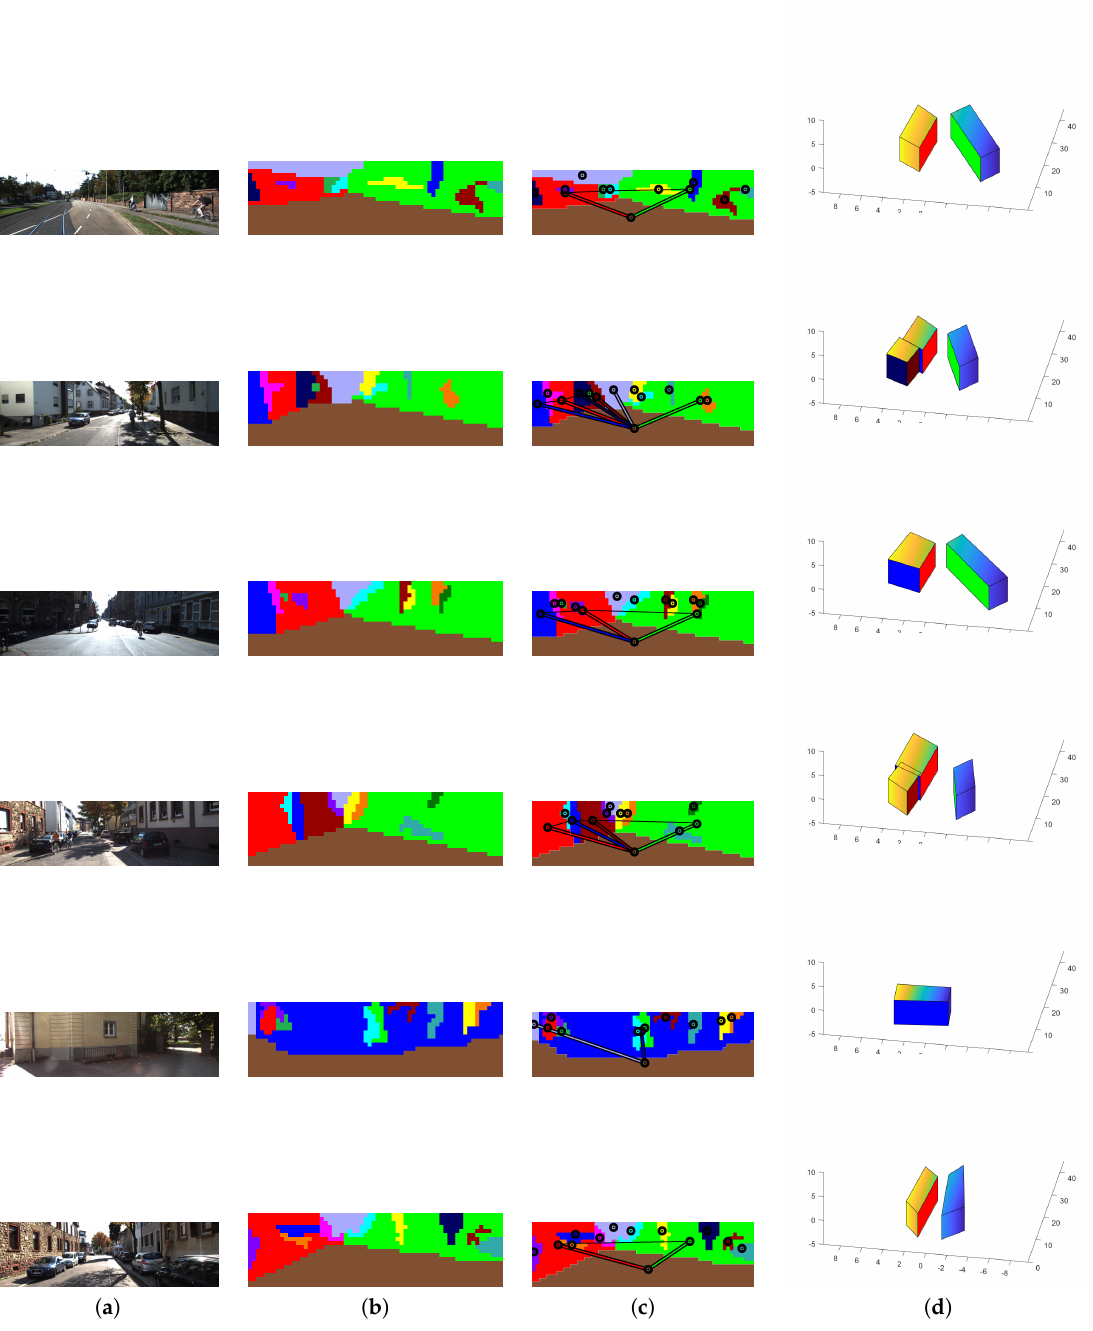
Figure 10. Our HLS extraction method on the KITTI dataset. ( a ) Input image; ( b ) Orientation segmentation; ( c ) Graph analysis; ( d ) HLS